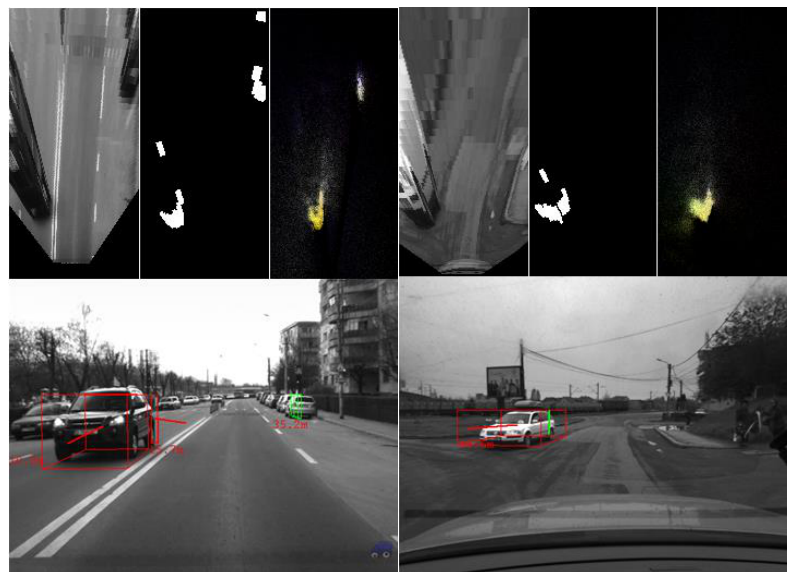
Figure 15. ( Left ) Detected incoming vehicle, at a relative speed of around 100 km/h; and ( Right ) diagonally crossing object, on patched road. The uneven road surface does not impede detection.